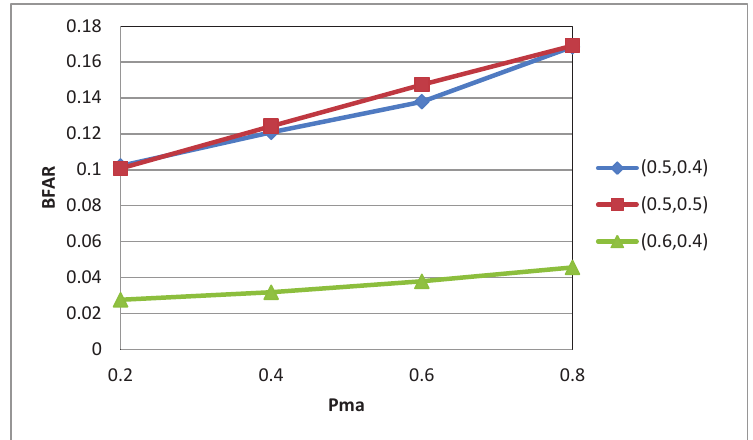
= 2 r , when r ma e c